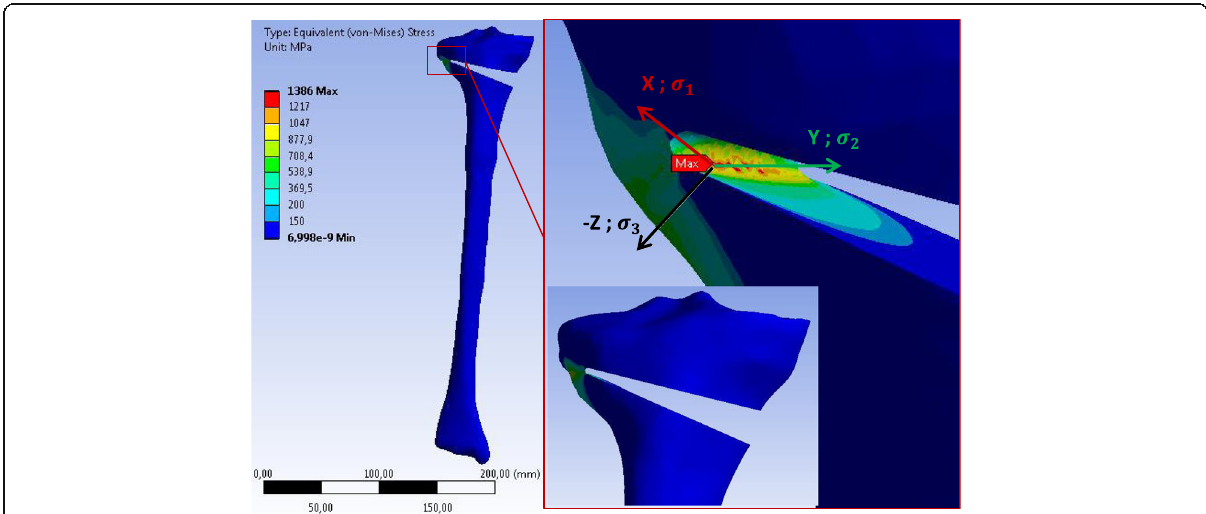
Fig. 10 Equivalent (von-Mises) stress in the specimen SNH obtained with 3D linear FEA: Only the result for case study H is represented. The stress values correspond to an opening angle of 10°. The specimen has been slightly rotated in the zoom-view on the right to show the location of the reference point where the equivalent (von-Mises) stress was maximum